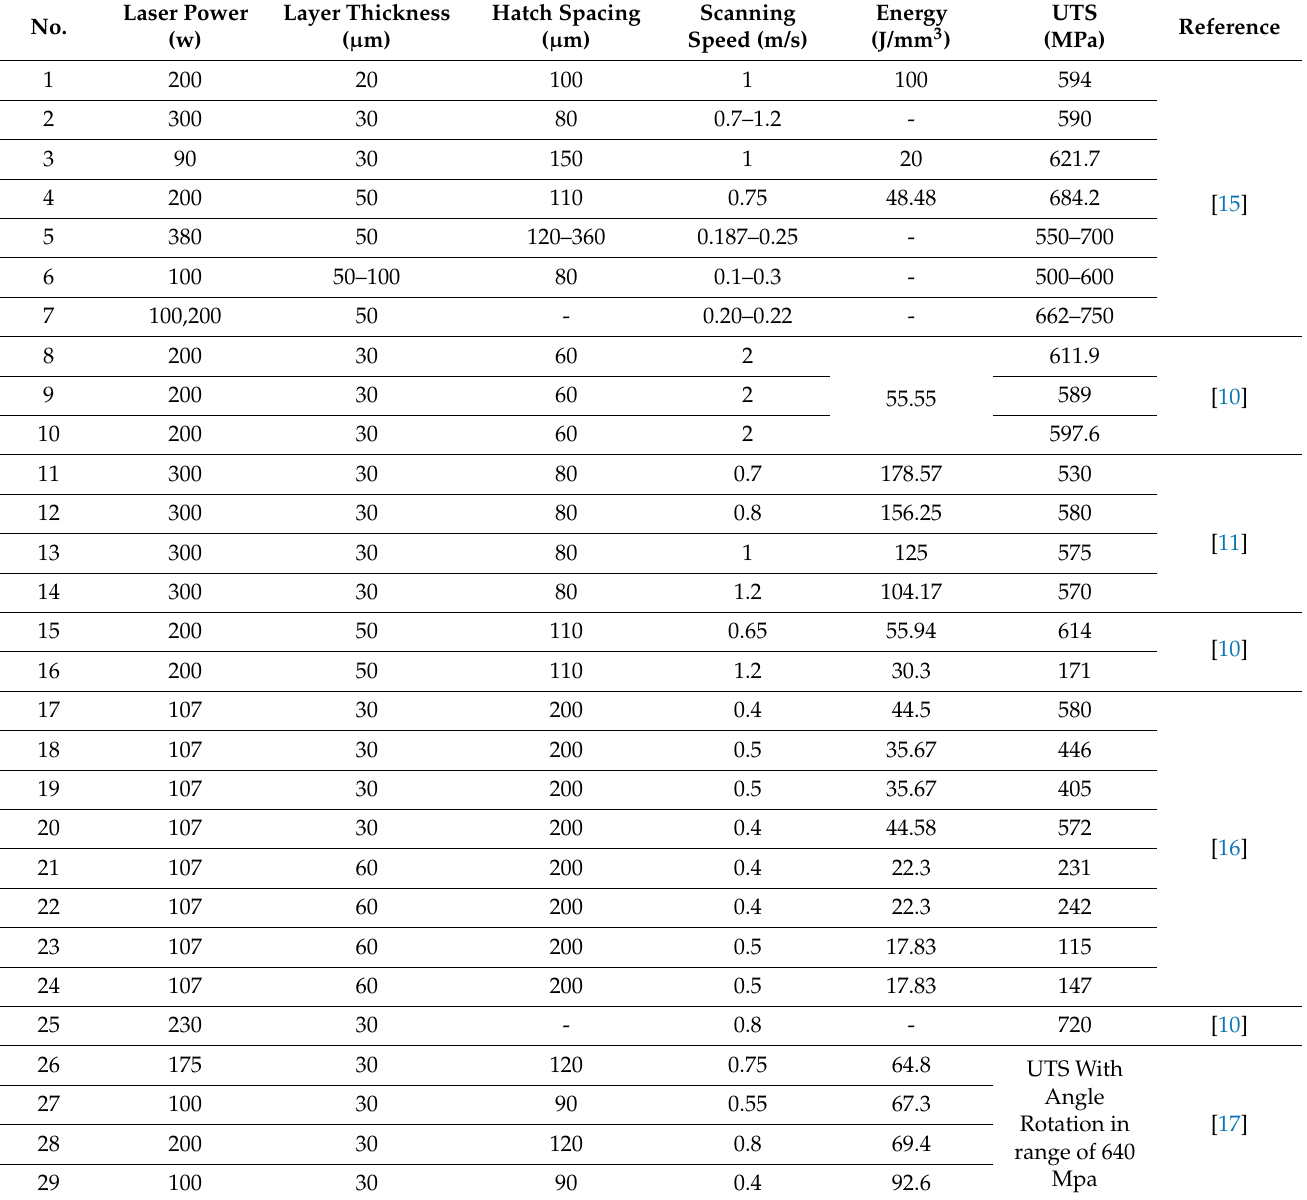
Table 1. Tensile strength at different process